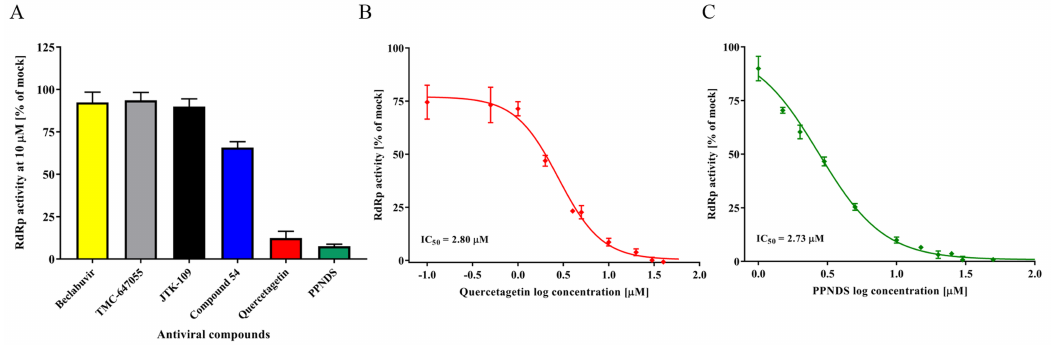
Figure 2. The inhibitory activity of selected non-nucleoside inhibitors against the FCV RdRp. ( A ) The effect of six NNIs was evaluated against FCV RdRp activity at a fixed concentration of 10 µ M. Dose-response inhibition trends for PPNDS ( B ) and quercetagetin ( C ) for half maximal inhibitory concentration (IC 50 ) determinations. The compounds were tested at concentrations between 0.1 and 100 µ M against the FCV RdRp and activity levels were compared to DMSO treatment (vehicle only). Triplicate values from three independent experiments are plotted as the mean ±